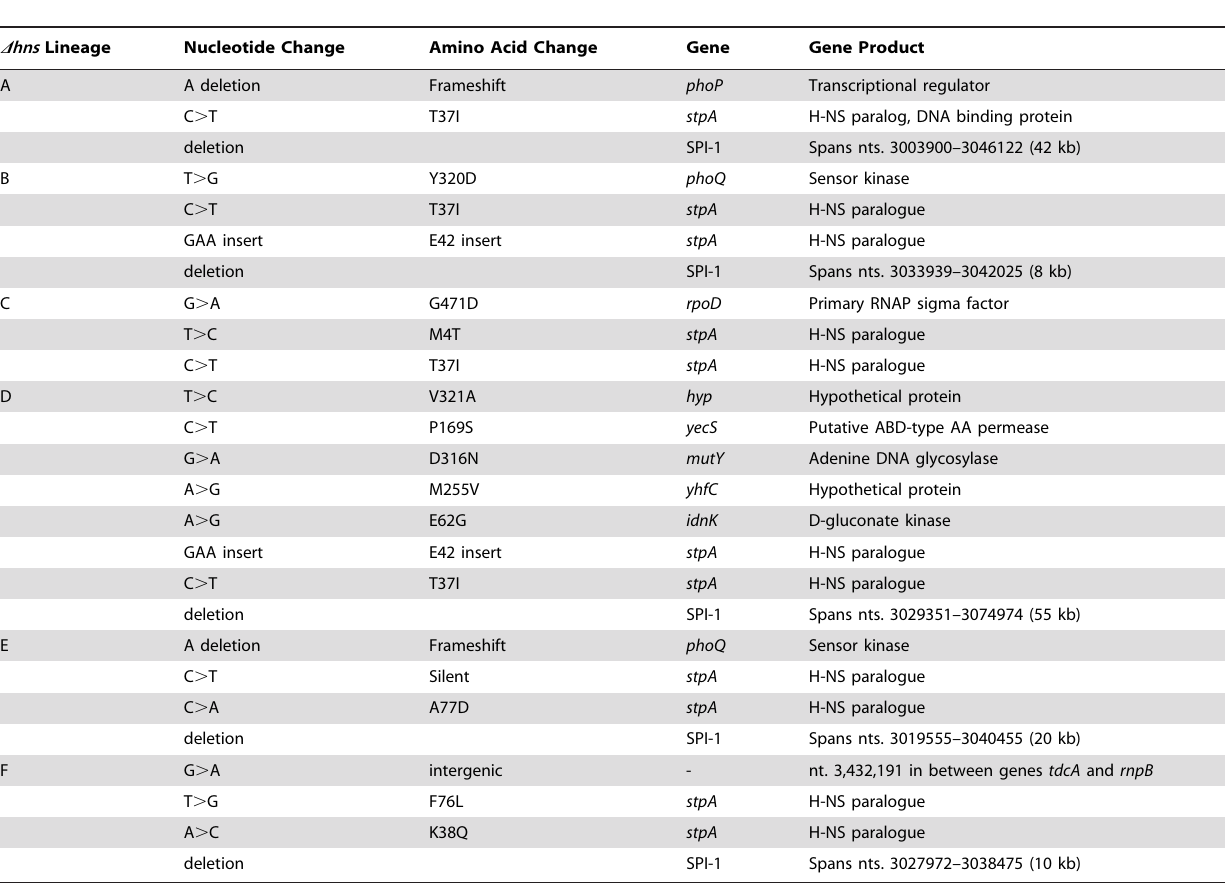
Table 1. Summary of the genetic changes specific to the hns mutant